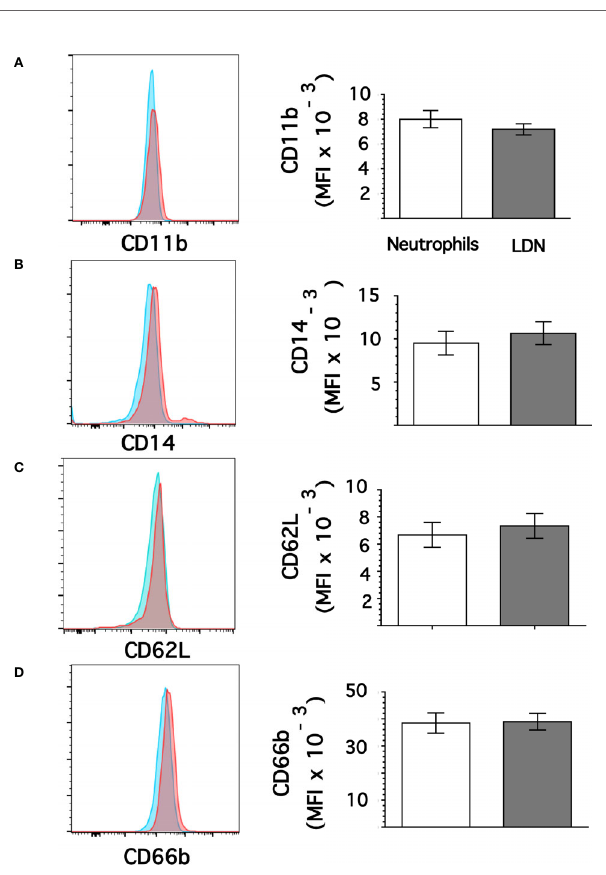
FIGURE 3 | Low-density neutrophils displaysimilar expressionof CD11b, CD14, CD62L, andCD66b as neutrophils. Leukocytes in blood from young healthy donors were separated by density gradient centrifugation. Then, neutrophils(blue) or LDN (red) were analyzedby fl ow cytometry for membrane expressionof CD11b (A) , CD14 (B) , CD62L (C) , CD66b (D) . Left panels are representative histograms of 11 experiments with similar results. Right panelsshow the Mean ± SEM of the mean fl uorescence intensity(MFI) for each Low-Density Neutrophils Have a Higher Phagocytic Capacity Than Neutrophils Phagocytosis is a fundamental antimicrobial function of normal mature neutrophils. Since LDN seemed to be more responsive than neutrophils,thephagocyticcapacityofthesecellswasexplorednext. Neutrophils were mixed with antibody-opsonized latex beads in ordertoassessphagocytosis.About15%ofnormalneutrophilswere able to phagocytose non-opsonized beads ( Figure 7 ); while almost 80% of neutrophils could ingest antibody-opsonized beads ( Figure 7 ). In the same way, the phagocytic index (number of beads ingested by 100 neutrophils) was much higher for antibody- opsonized beads (140 ± 5.7, mean ± SEM, n = 5) than for non- opsonized beads (28.8 ± 11.3, mean ± SEM, n = 5). In an analogous way, total mononuclear cells were mixed with antibody-opsonized latex beads to assess phagocytosis. After a 30-min incubation at 37°C,therewerefewcellscapableofingestingbeads( Supplemental Figure 4 ). These phagocytic cells could be monocytes or LDN.